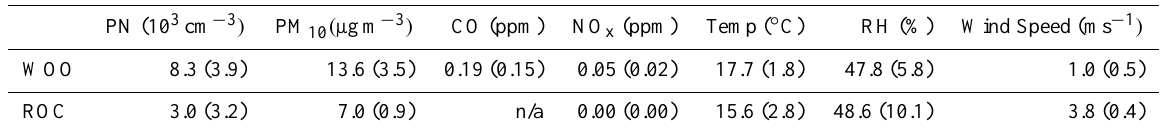
Table 3a. Average values of measured parameters of WOO and ROC from 08:00–16:00 on 17 Jul 2009. A standard deviation showed in